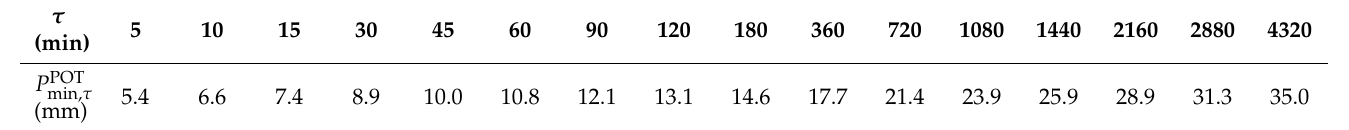
(mm) taken as a threshold in the POT min, τ